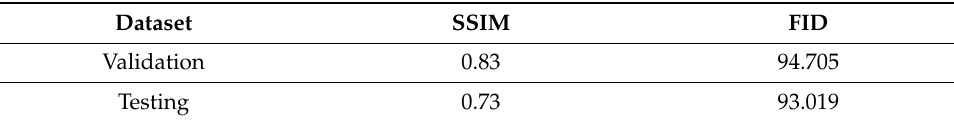
Table 4. Result of cGAN-TV on validation and testing